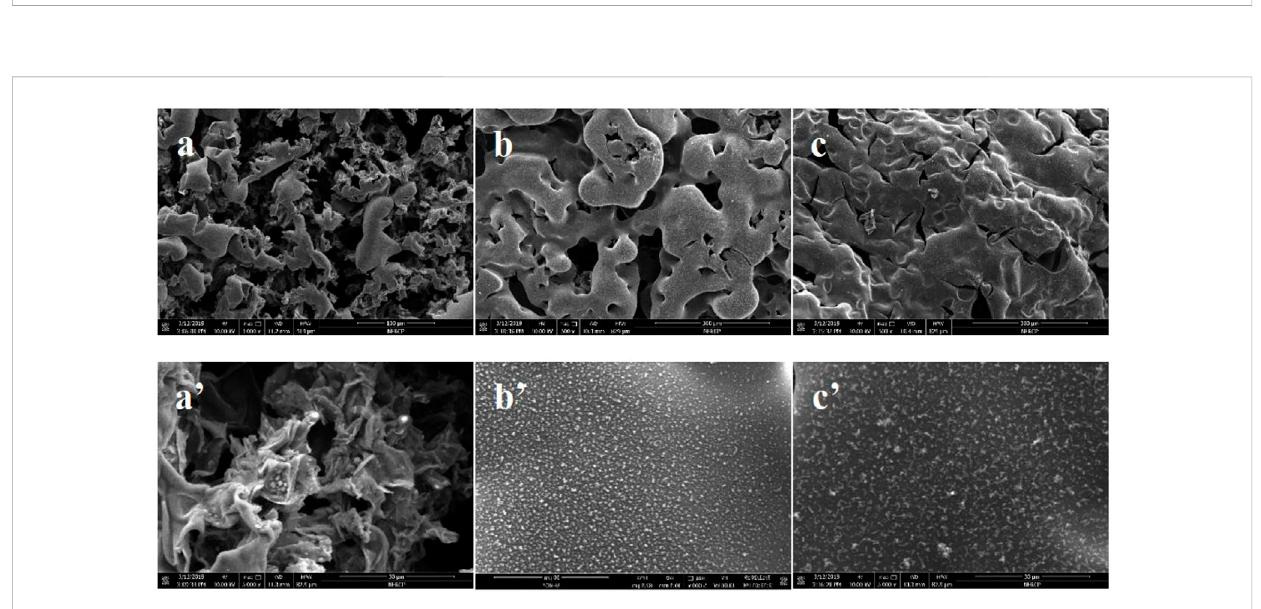
FIGURE 10 SEM image of residual carbon layer of PLA/P-PPD-Ph/ECE fl ame retardant composite after cone calorimeter test, (A) PLA/P-PPD-Ph/ECE-0 ‰ , (B) PLA/P-PPD-Ph/ECE-4 ‰ , (C) PLA/P-PPD-Ph/ECE-8 ‰ (a ’ ) PLA/P-PPD-Ph/ECE-0 ‰ , (b ’ ) PLA/P-PPD-Ph/ECE-4 ‰ , (c ’ ) PLA/P-PPD-Ph/ECE-8 ‰ are magni fi ed 5000 times.